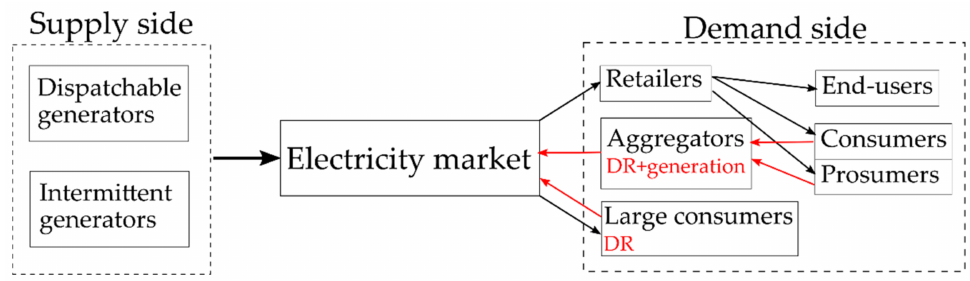
Figure 11. Aggregators’ key role in the future electricity